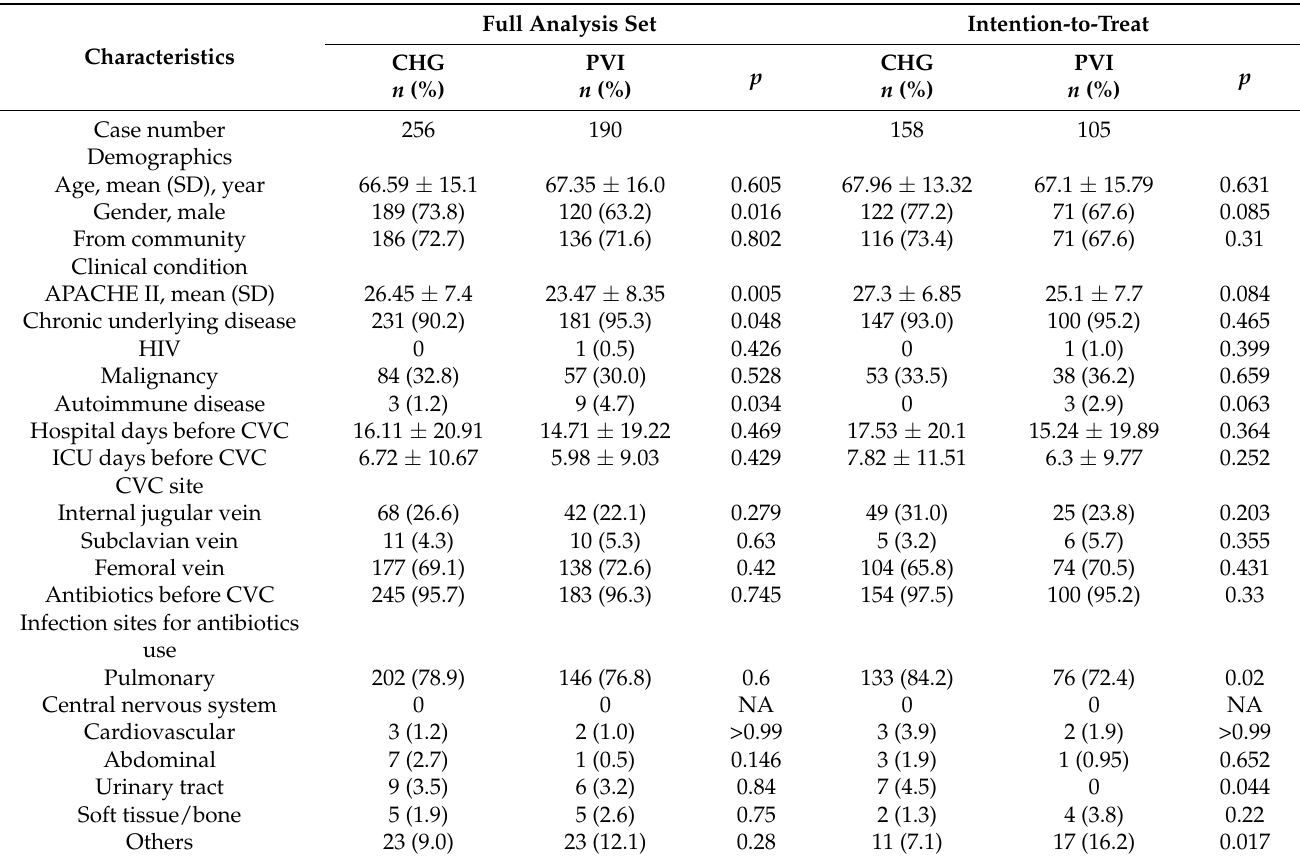
Table 1. Demographics and clinical characteristics of study participants.